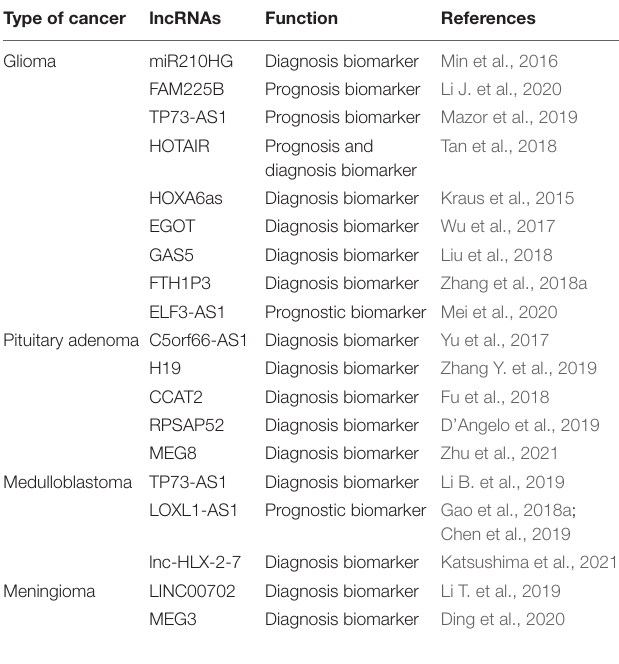
TABLE 1 | Prognostic and diagnostic LncRNA biomarkers for brain